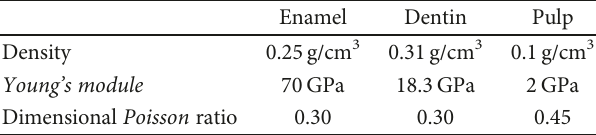
Table 1: Mechanical properties used in the analysis. Enamel